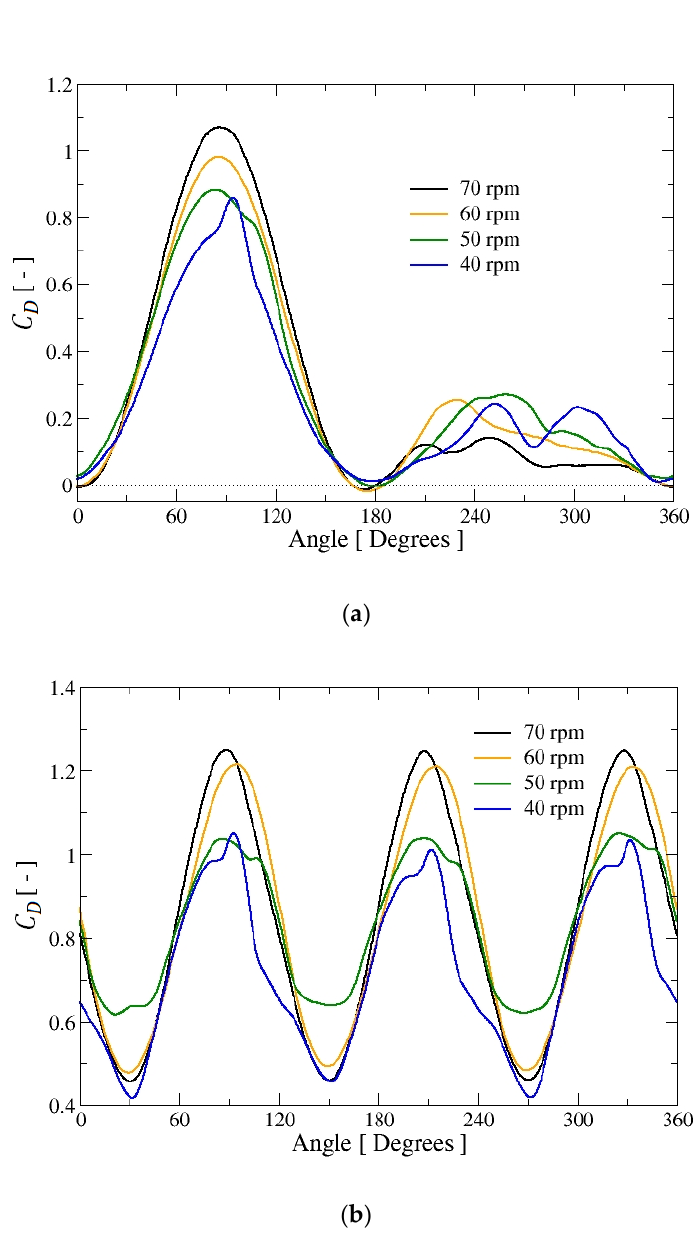
Figure 6. Thrust coefficient evolution along a revolution for different values of λ . ( a ) Single blade and ( b ) three blades.